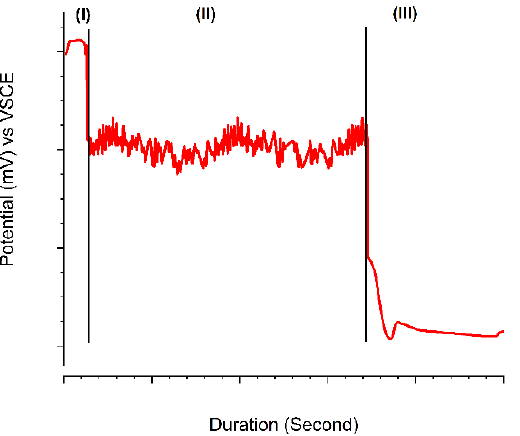
Figure 7. Schematic figure with corresponding stages of galvanostatic tests for specimens with different residual stress magnitude. Region 1 is the incubation region, region 2 is metastable pitting and SCC initiation and region 3 is the stable pitting and SCC propagation region namely. The duration and potential of each region vary with the variation of tensile RS on the surface.